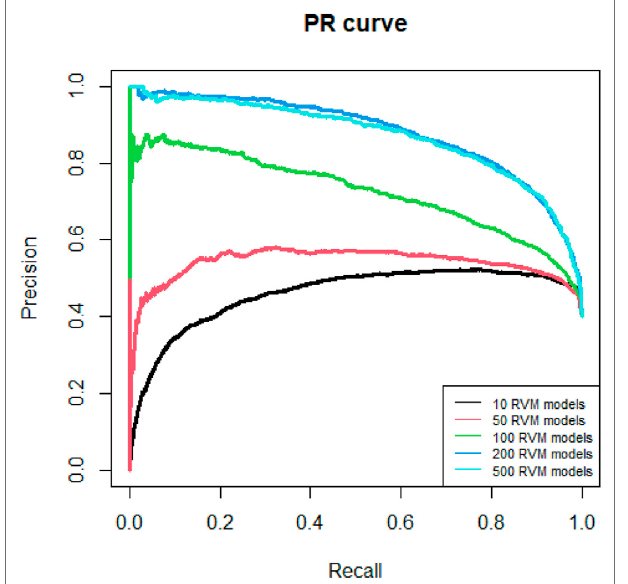
FIGURE 3 | PR curves of different RVM models.